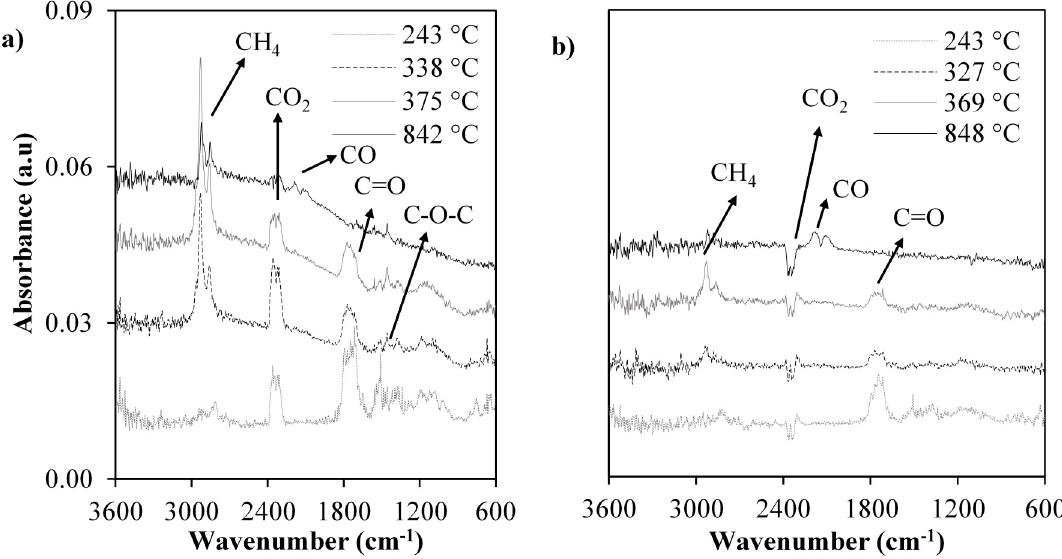
Figure 3. FTIR spectra obtained at the maximum decomposition rates during pyrolysis of ( a ) biomass and ( b ) biomass/catalyst 1:1 at 10 °C min − 1 . Catalyst: Rh-Pt/CeO 2 -SiO 2 .